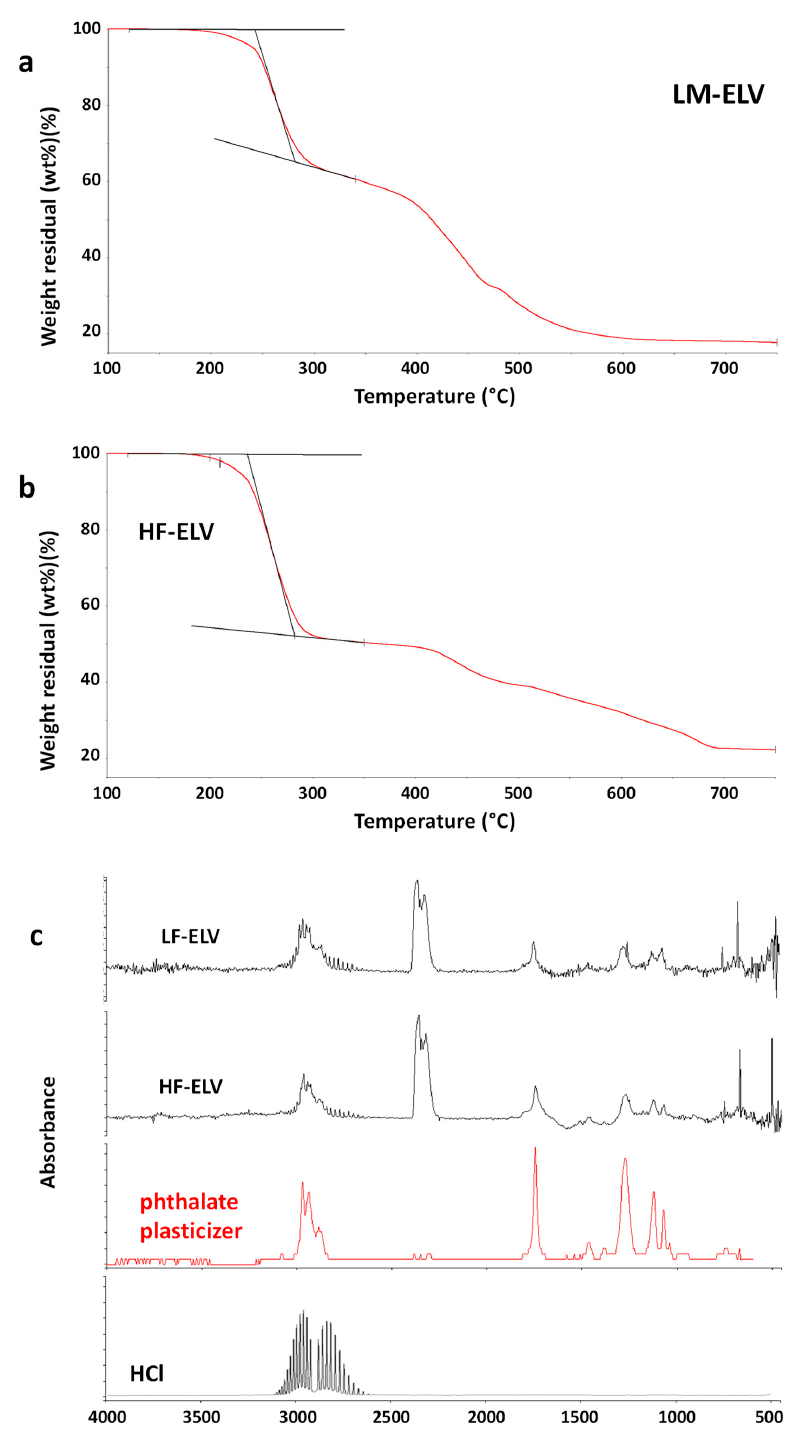
Figure 8. TG curves of the samples LF-ELV ( a ) and HF-ELV ( b ) in the temperature range 100–750 ◦ C. FTIR spectra of evolved gases from LF-ELV and HF-ELV samples at 200 ◦ C under air flow. The gas spectra of an alkylphthalate plasticizer and hydrochloric acid are reported for comparison ( c ).